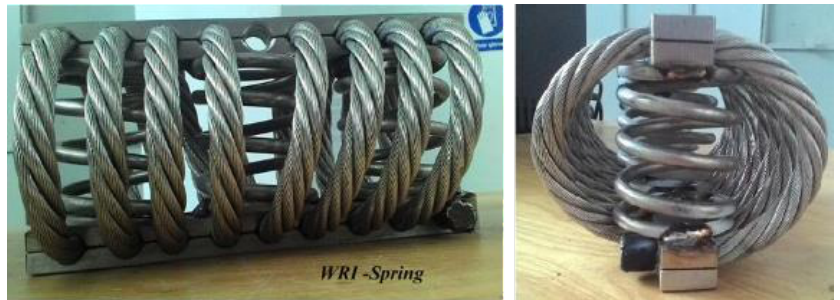
Figure 5. Fabricated